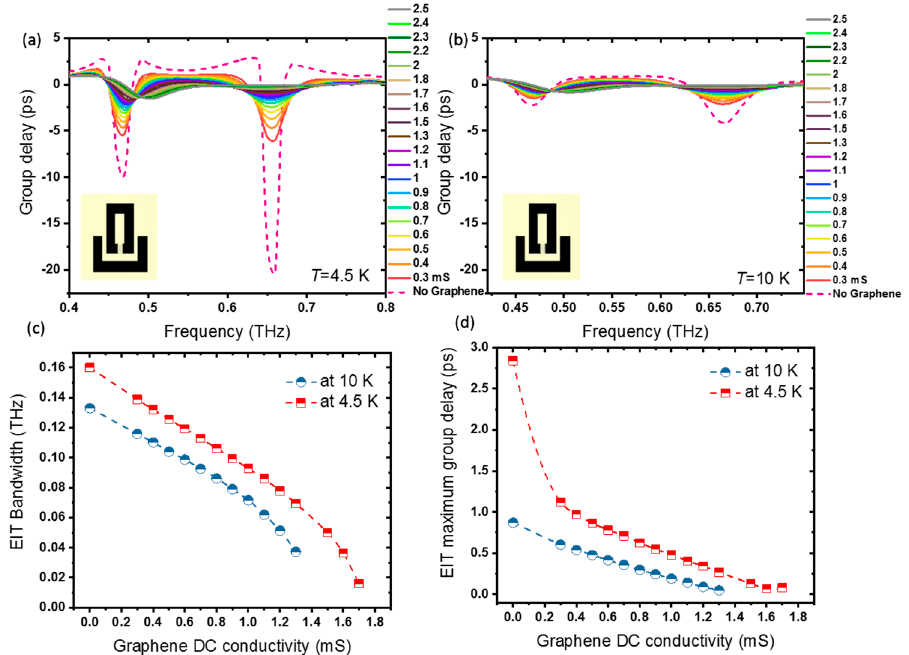
Figure 8. Group delay through the hybrid photonic integrated circuit for different graphene con- ductivities: at ( a ) T = 4.5 K, far from the Nb superconducting transition temperature T c , and ( b ) at T = 10 K, where Nb is no longer in the superconducting quantum phase. ( c ) The bandwidth of the transparency window and ( d ) EIT maximum group delay through the metamaterial photonic inte- grated circuit, with hybrid graphene-Nb SRRs, as a function of graphene conductivity at T = 4.5 K < T c and at T = 10 K > T c